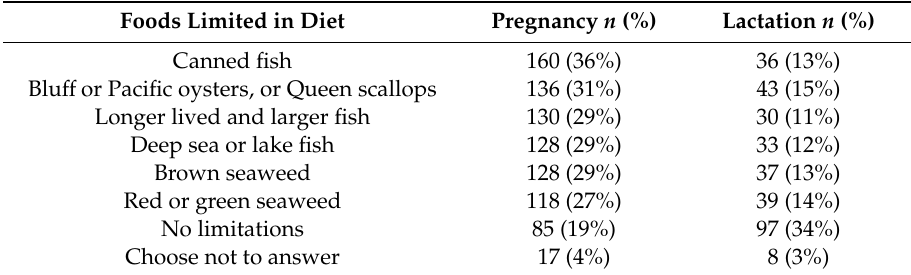
Table 4. Foods and beverages avoided in the diet during pregnancy and lactation. Pregnancy Lactation Foods and Beverages Avoided n (%) n (%) Alcohol 408 (92%) 176 (62%) Raw (unpasteurised) milk and milk products 379 (86%) 99 (35%) Raw, smoked, or pre-cooked fish or seafood 371 (84%) 57 (20%) Cold pre-cooked meats 335 (76%) 39 (14%) Processed meats 315 (71%) 42 (15%) Ready-made salads 313 (71%) 28 (10%) Tahini 300 (68%) 29 (10%) Foods containing raw egg 296 (67%) 24 (8%) Soft-serve ice cream 288 (65%) 37 (13%) Hummus 255 (58%) 16 (6%) Soft pasteurised cheese 232 (52%) 35 (12%) Cream or custard 212 (48%) 29 (10%) No foods or beverages avoided 52 (12%) 84 (30%) Other *